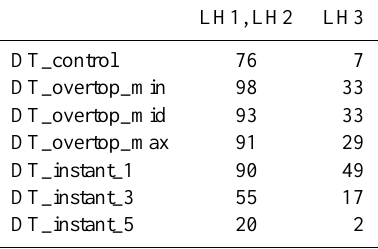
Table 2. Scenario-specific behavioural simulation count for indi- vidual likelihood measures. Note: all simulations deemed to be be- havioural after application of LH1 (final breach depth) were re- tained for conditioning on LH2 (breach thalweg elevation